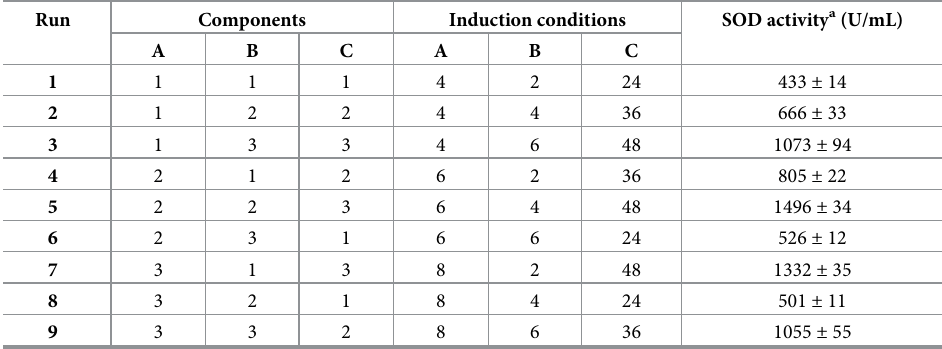
Where: A = time interval between inoculation and induction (h), B = lactose concentration (g L -1 ), C = cultivation time after induction (h). a Results are mean ± SD of three